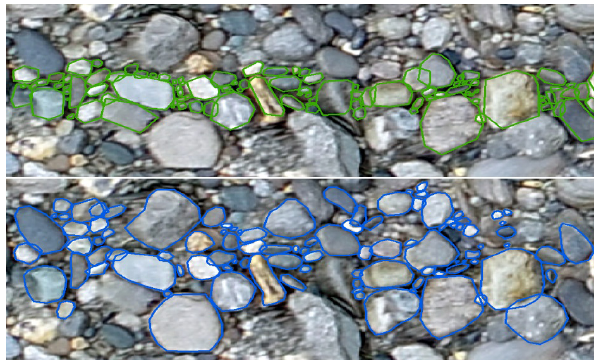
Figure 7. Repeated annotations of the same tile by two